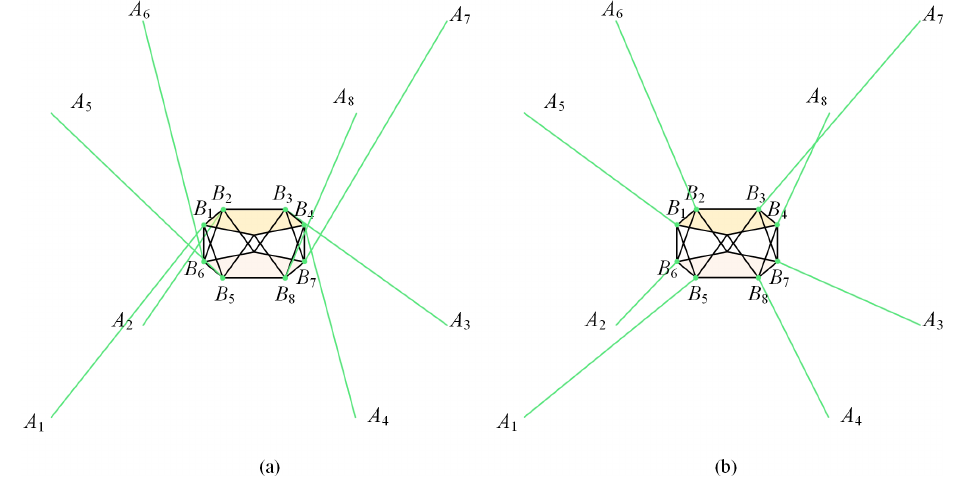
Figure 4. Cable layout scheme.